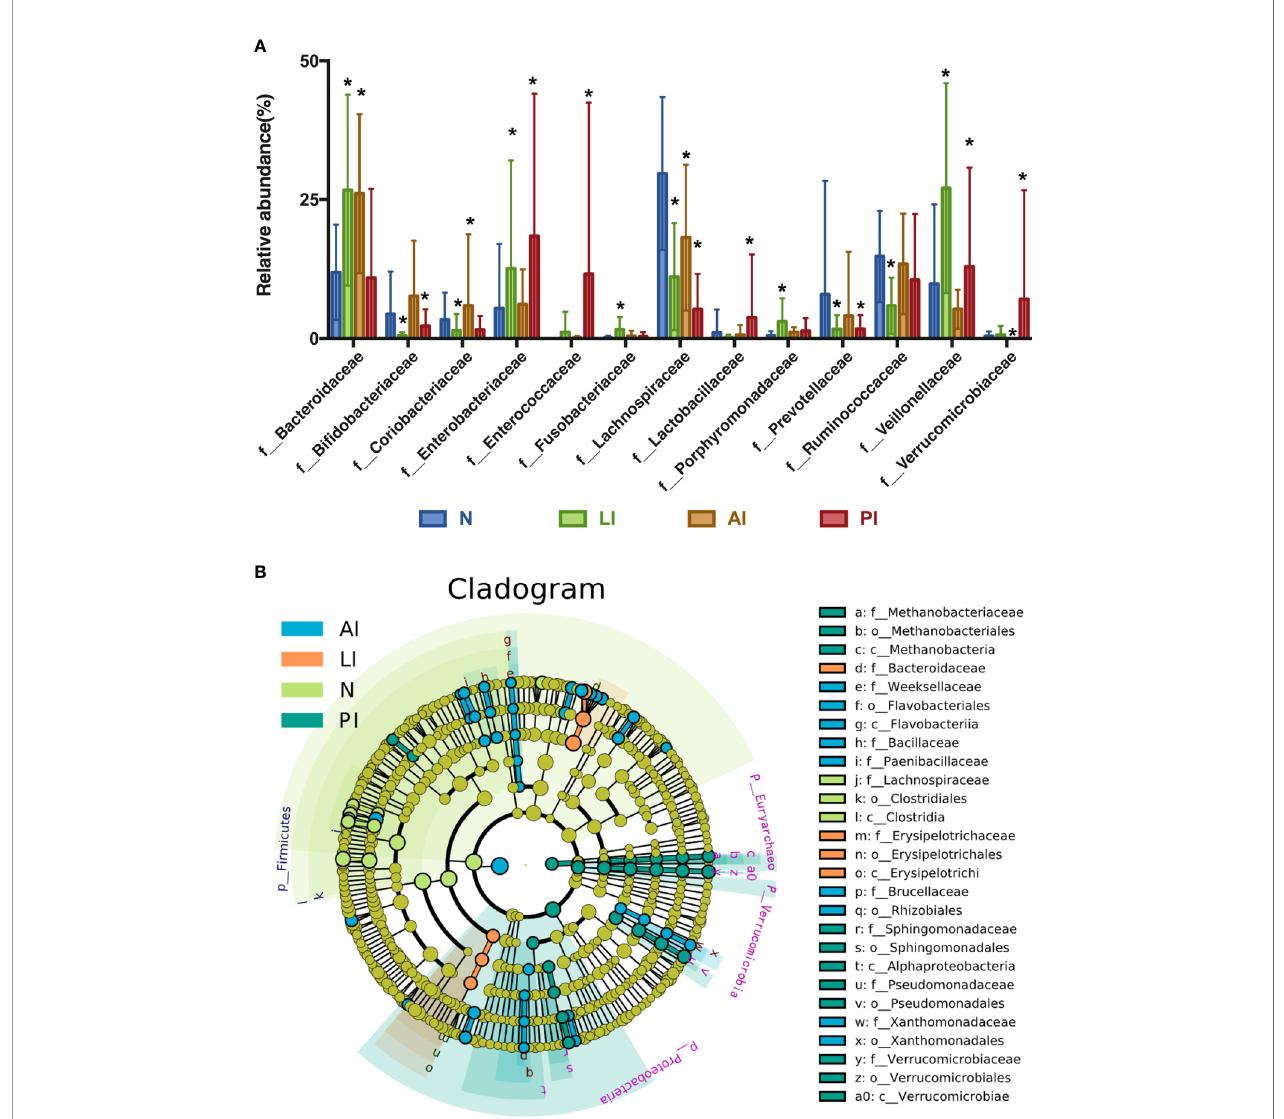
FIGURE 4 | (A) The most abundant microbiotic components (at the family level) of each group. *P < 0.05. (B) LEfSE analysis reveals bacterial taxa, the levels of which differ signi fi cantly among